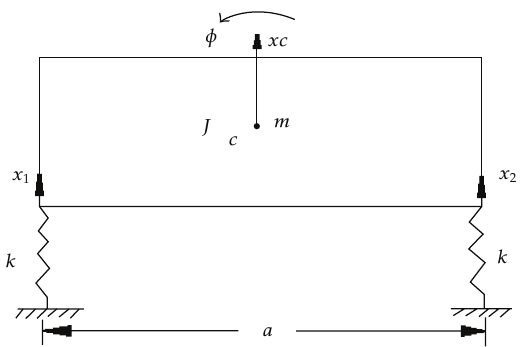
Figure 4: Structural diagram of the cuboid rigid body.